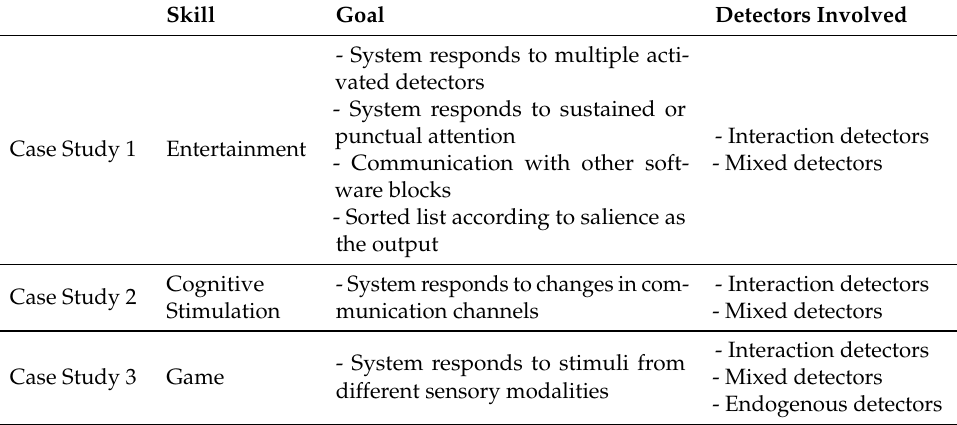
Table 1. A summary of the three case studies that are presented in this